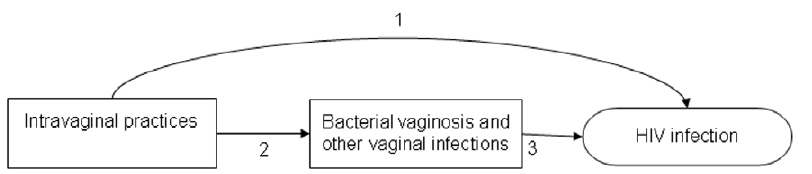
Figure 1. Simplified hypothesized pathways linking intravaginal practices and HIV. Intravaginal practices are hypothesized to cause physical or chemical damage to vaginal epithelium. In response, changes in vaginal flora associated with bacterial vaginosis occur, or colonization by other vaginal pathogens occurs. These conditions facilitate HIV transmission. Intravaginal practices might also increase the transmission of HIV through a direct effect or other pathways. Numbers refer to the objectives of the review. Objective 1 includes the estimation of the association between intravaginal practices and HIV infection. Objective 2 estimates the association between intravaginal practices and vaginal infections. Objective 3 estimates the association between disrupted vaginal flora, bacterial vaginosis or other vaginal infections and HIV-1 acquisition.